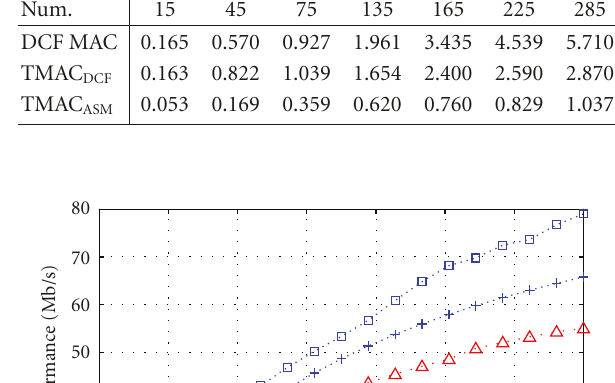
Table 5: Average delay (s) at 216 Mb/s. Num.